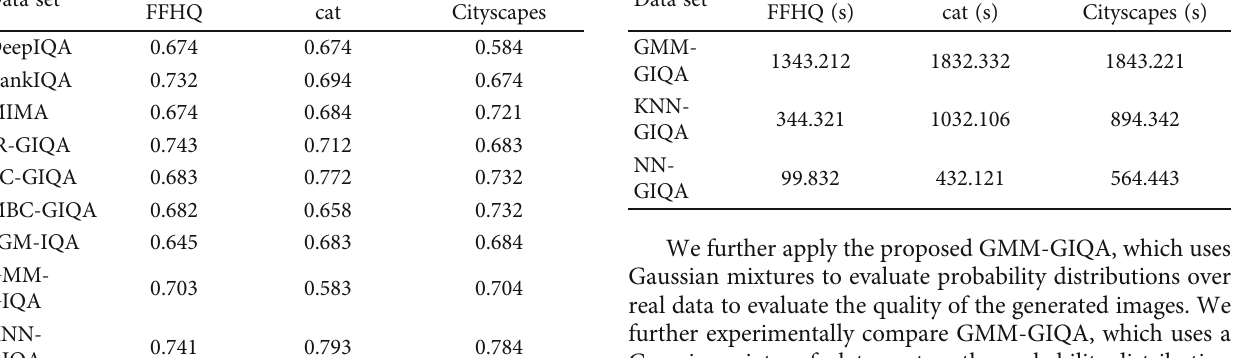
Table 1: Di ff erent IQA algorithms on LGIQA data sets. Data set